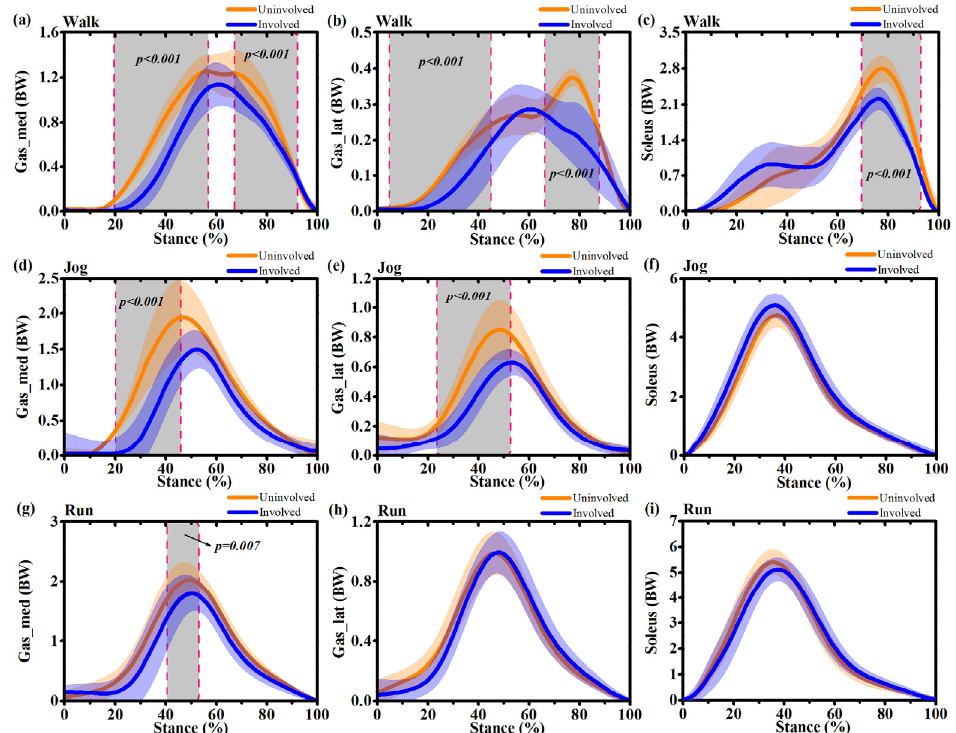
Figure 7. Mean and standard deviation of estimated gas_med (gastrocnemius medialis), gas_lat